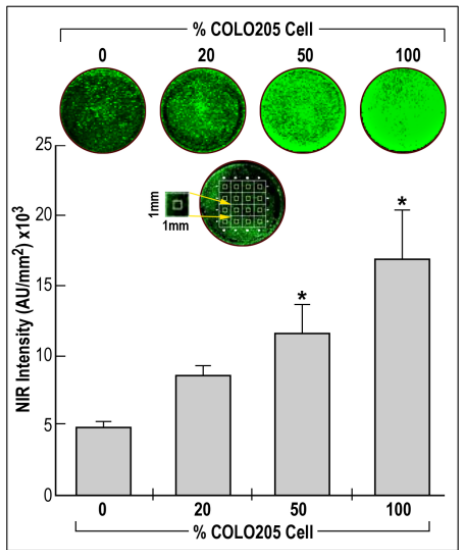
Figure 4. The relationship between NIR intensity and the number of EGFR positive carcinoma cells (COLO205) in a heterogeneous mixture with non-transformed cells (IEC6). 20 nM EGF-NIR was incubated for 20 min at 37 °C with a heterogeneous culture of both COLO205 and IEC6 cells at different complementary ratios (mean ± SD, n = 9); The NIR intensity was estimated at the following conditions: resolution: 170–340 microns; pixel area: 0.03 mm 2 ; quality: medium-low; focus offset: 3; channels: 800 nm; intensity: 1; * p < 0.05 vs. scrambled or control. Significance: * p < 0.05 vs. 0% COLO205 cells. Insert: NIR scans; Lower insert: a photograph of a calibration scale suitable for endoscope with a resolution of 1 pixel (1 mm 2